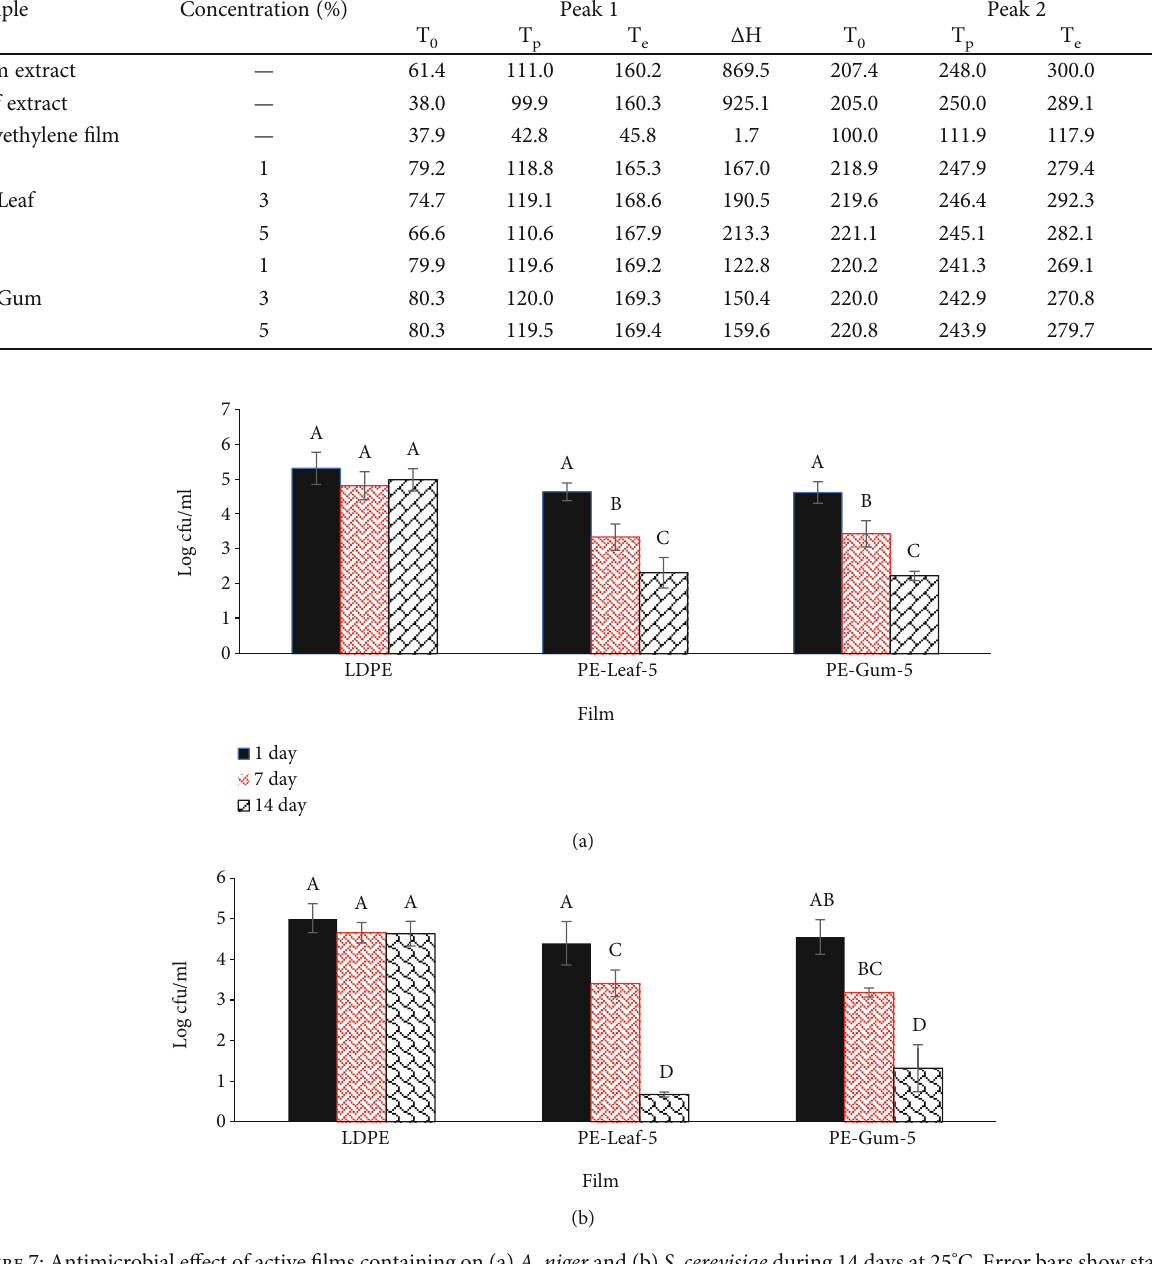
Figure 7: Antimicrobial e ff ect of active fi lms containing on (a) A. niger and (b) S. cerevisiae during 14 days at 25 ° C. Error bars show standard deviation (SD). Nonsimilar letters on each column indicate a signi fi cant di ff erence according to Tukey ’ s test ( P < 0 : 05